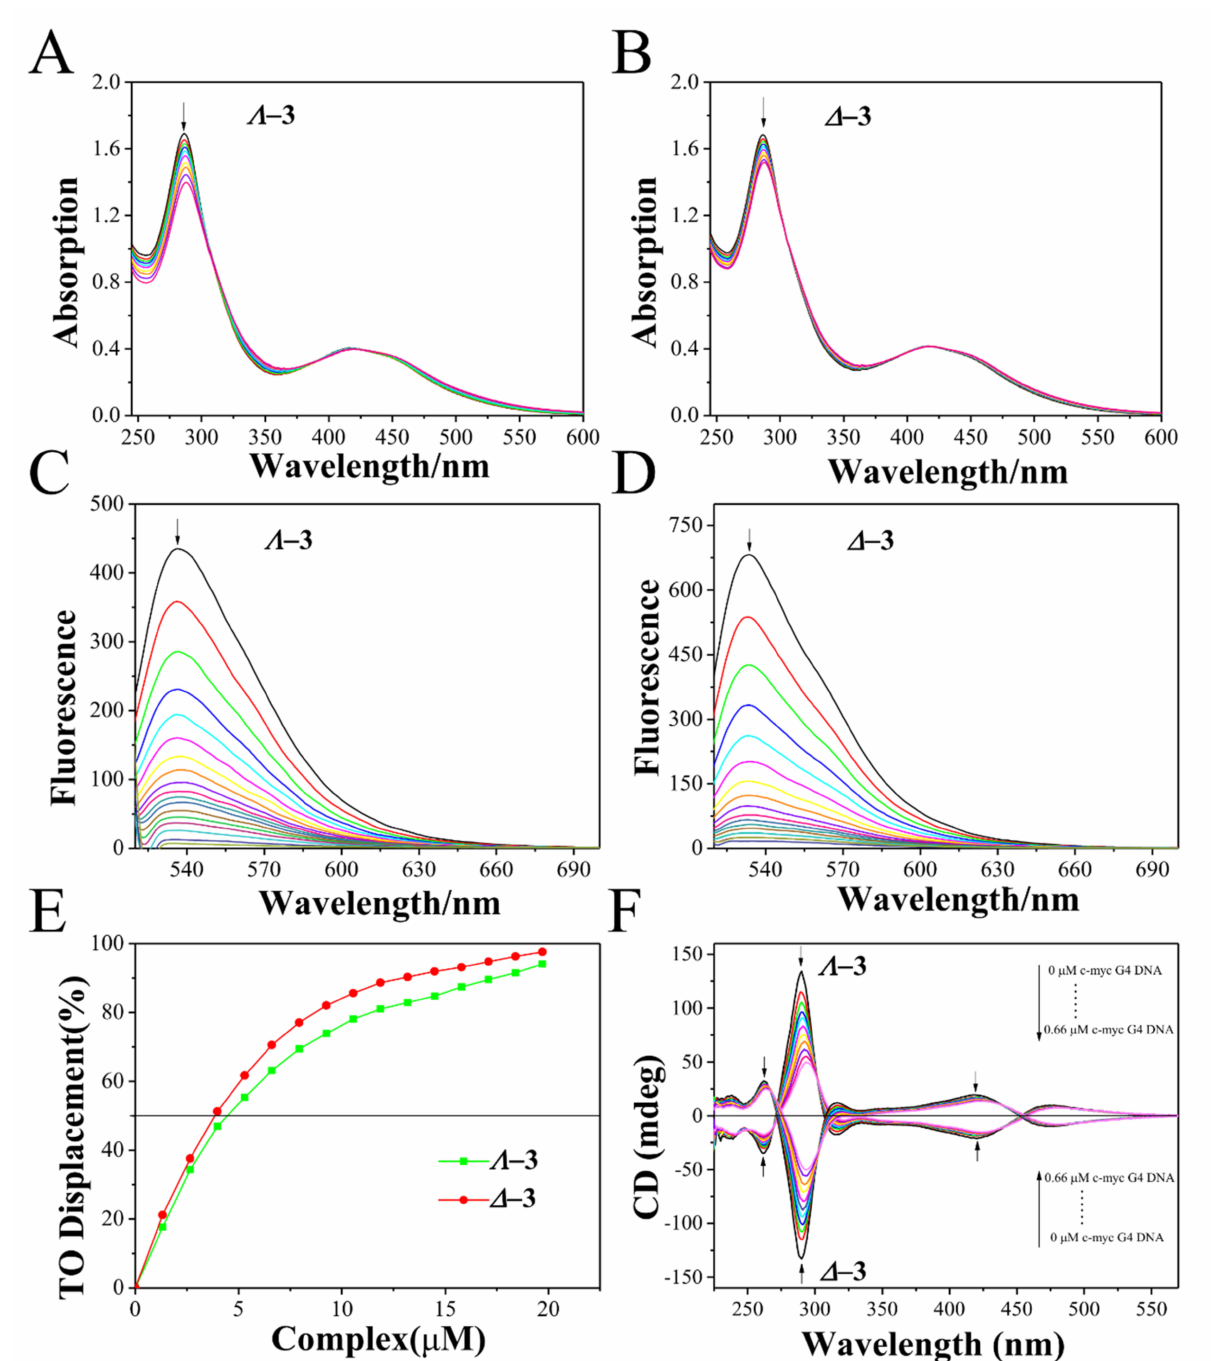
Figure 3. The binding properties of chiral DPPZ-based Ru(II) complexes with c-myc G-quadruplex DNA. The electronic spectra of Λ − 3 ( A ) and ∆ − 3 ( B ) at concentration of 20 µ M with the increasing of c-myc in the Tris–HCl–KCl buffer. The emission spectra of TO-c-myc system with the increasing of Λ − 3 ( C ) and ∆ − 3 ( D ), and ( E ) the DC 50 values of the relative TO displacement for c-myc G- quadruplex DNA by Λ − 3 and ∆ − 3 . [TO] = 1 µ M, [Ru] = 0–45 µ M, [c-myc] = 0.50 µ M, λ ex = 501 nm. ( F ) The CD spectra of Λ − 3 and ∆ − 3 upon the addition of c-myc G-quadruplex DNA in Tris-HCl-KCl buffer (pH